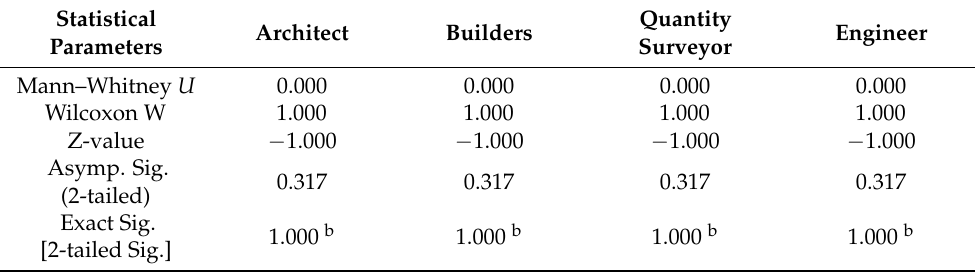
Table 14. Rating of Effective Adaptations of C4.0 in Technological